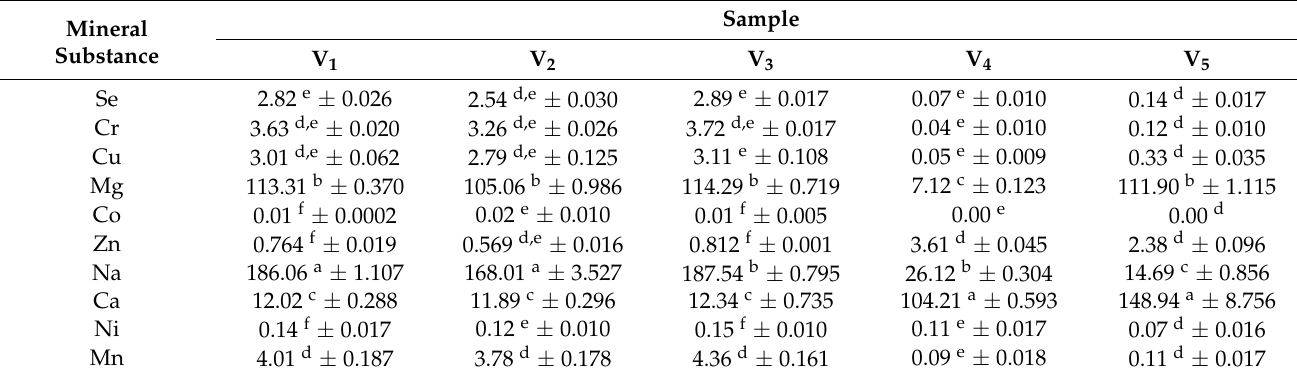
Table 2. Mineral content of banana peel and commercial balsamic vinegars